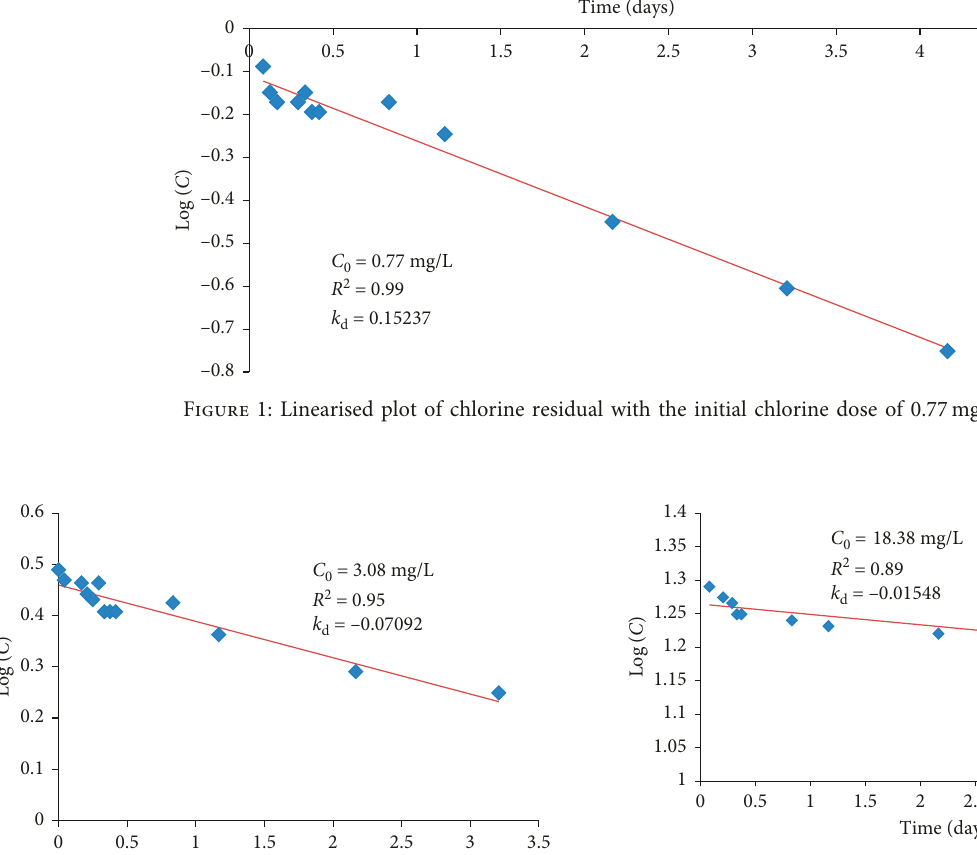
Figure 4: Linearised plot of chlorine residual with the initial chlorine dose of 18.38mg/L.